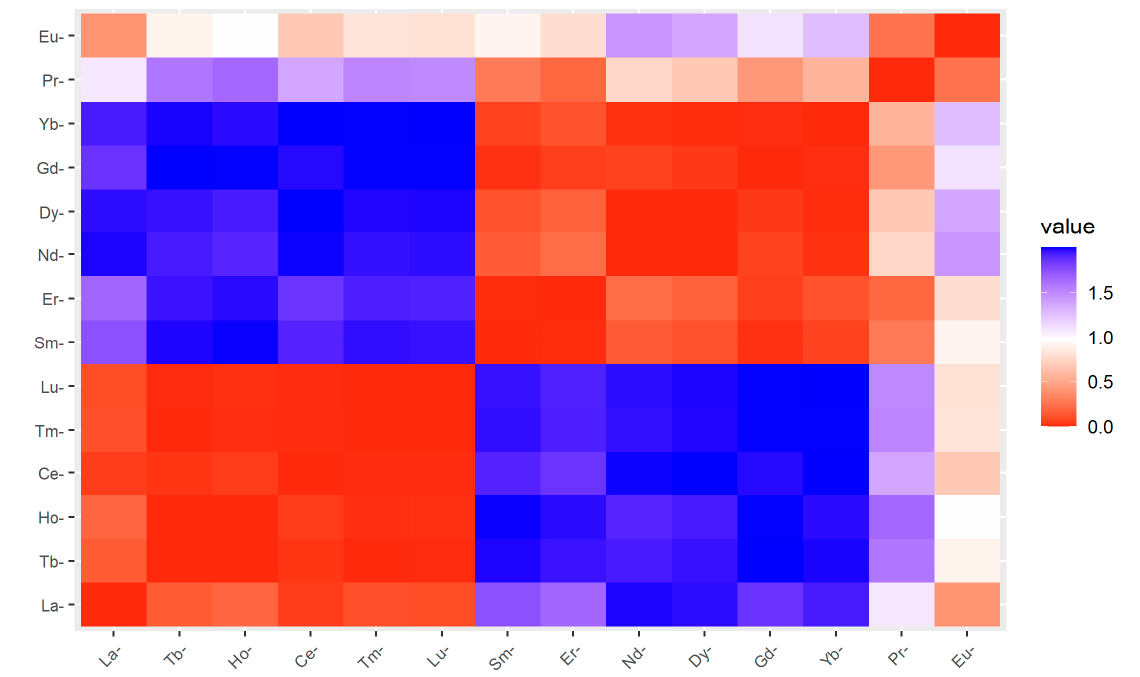
Figure 5. Heat map for the relationship between rare earth elements in sediment and A. marina .